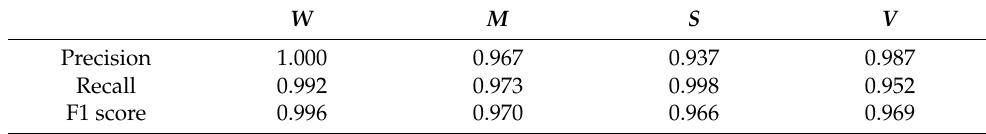
Table 7. Performance metrics estimated for S2 land cover classification.